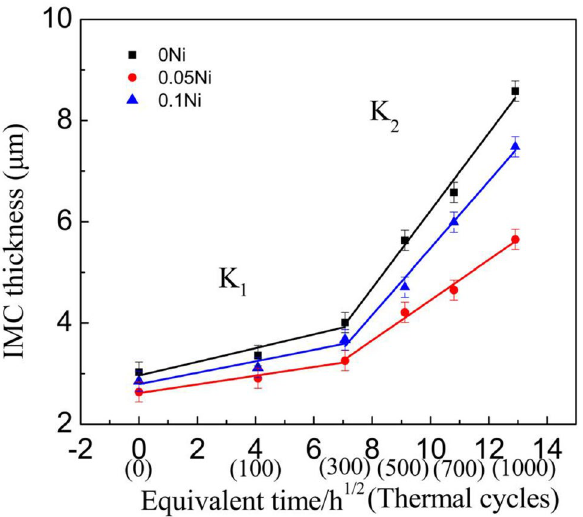
Figure 10. Relationship between IMC thickness and the square root of equivalent time.